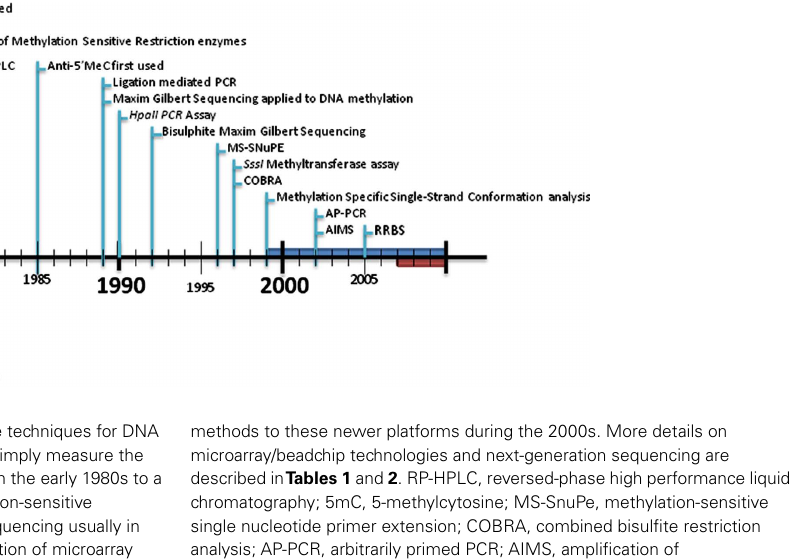
FIGURE 1 |Timeline of DNA methylation analysis. The techniques for DNA methylation analysis have developed from the ability to simply measure the amount of 5-methylcytosine within a particular genome in the early 1980s to a variety of basic comparative methods involving methylation-sensitive restriction enzymes, immunoprecipitation or bisulfite sequencing usually in combination with PCR up to the late 1990s.The introduction of microarray technology and next-generation sequencing saw the adaption of these earlier